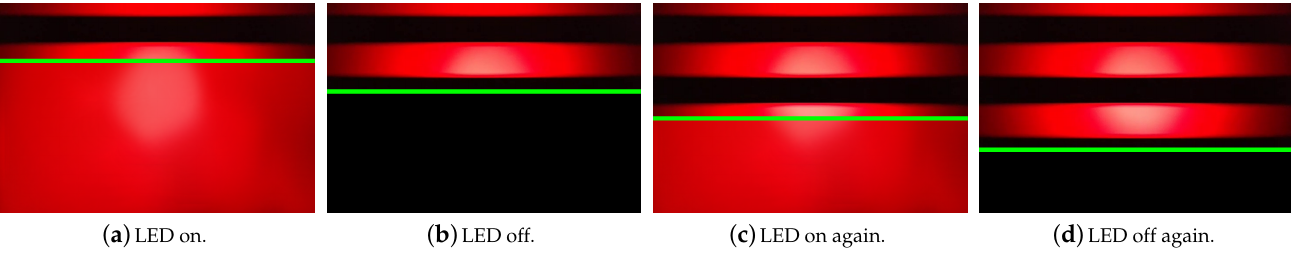
Figure 3. Plane with moving propeller captured by high-speed camera (left) and rolling-shutter camera (right) [20].